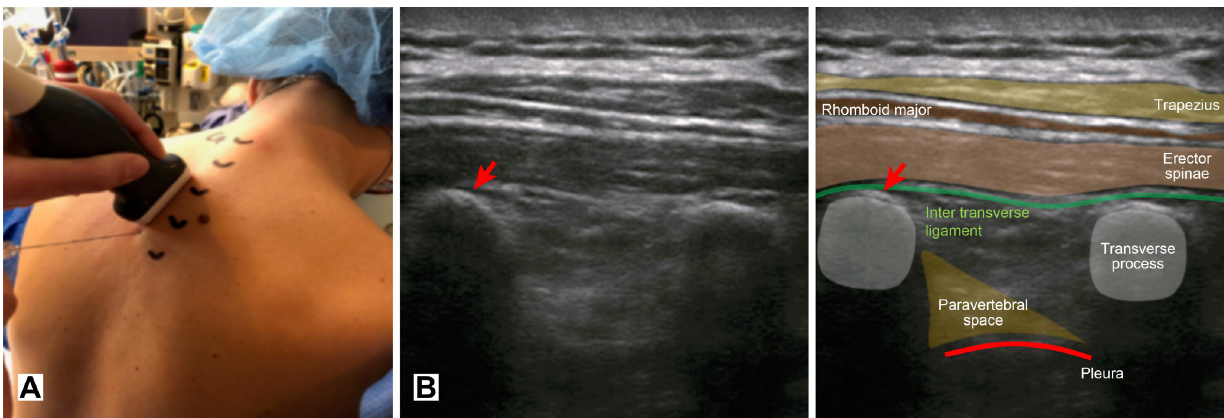
Fig 2. Technique description. A . Probe and needle placement. B . Echoanatomy and injection site (red arrow).